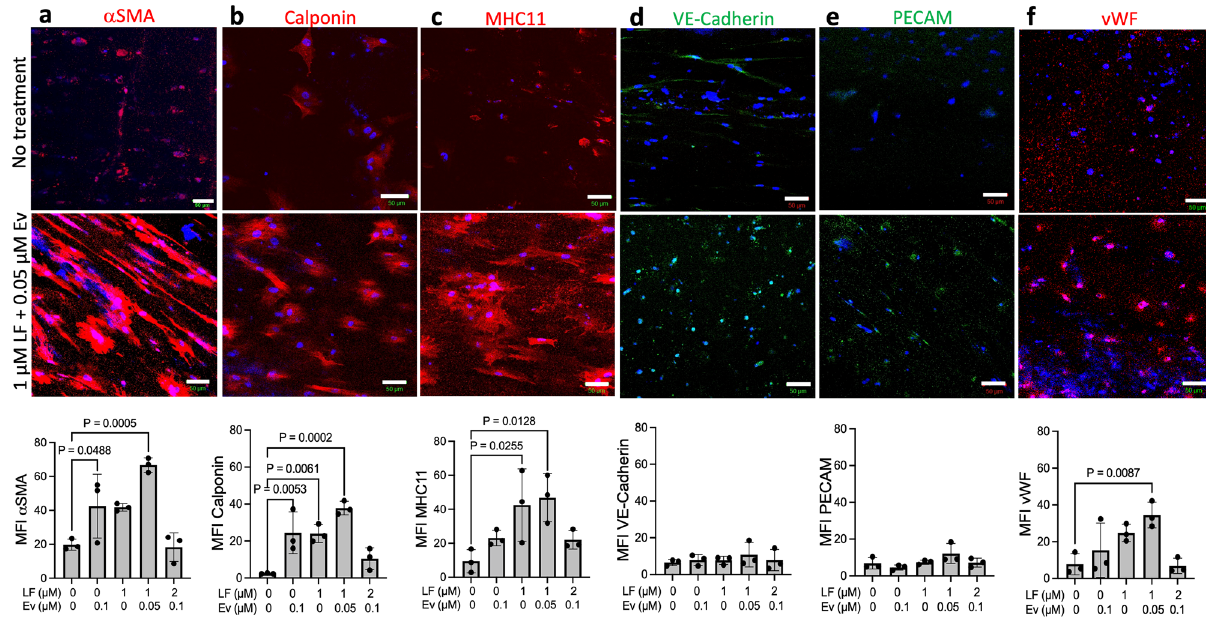
Figure 5. Lonafarnib and Everolimus treatment improves expression of contractile proteins in HGPS TEBVs. HGPS 167 CL2 TEBVs were matured for 3 weeks, treated with Lonafarnib (LF) and Everolimus (Ev) for 1 week and then processed for immunostaining. Representative images and quantification of SMC markers α-smooth muscle actin (αSMA, a ), calponin ( b ), and myosin heavy chain-11 (MHC11, c ) and endothelial markers vascular endothelial cadherin (VE-Cadherin, d ), platelet endothelial cell adhesion molecule (PECAM, e ), and von Willebrand factor (vWF, f ). Scale bar: 50 µm. Data presented as mean ± SD. N = 3 experiments per group. Results are compared to the reference condition without Lonafarnib and Everolimus using Dunnett’s test. Representative images for the 1 µM Lonafarnib treatment, 0.1 µM Everolimus treatment, and 2 µM Lonafarnib + 0.1 µM Everolimus treatment conditions are shown in Fig.